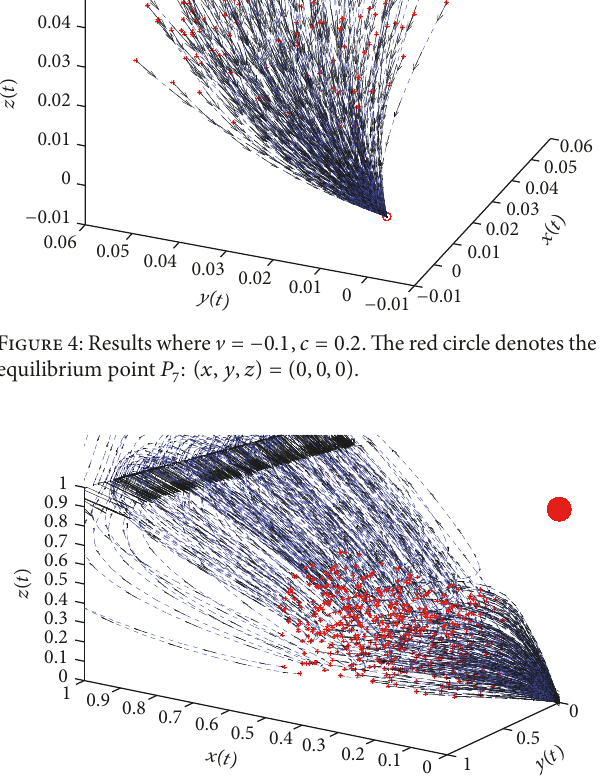
Figure 5: Results where V = −0.2 , 𝑐 = −0.1 . The shaded red circle denotes the equilibrium point 𝑃 1 : (𝑥,𝑦, 𝑧) = (0,0, 1) . One can see that, indeed, under these choices for V and 𝑐 , 𝑃 1 is indeed a saddle point as predicted by our stability